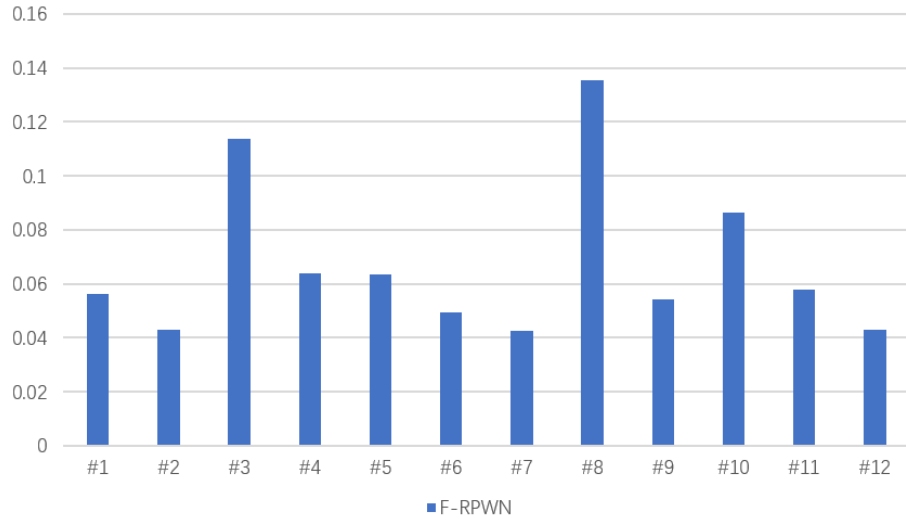
Figure 7. Each failure mode F-RPWN.